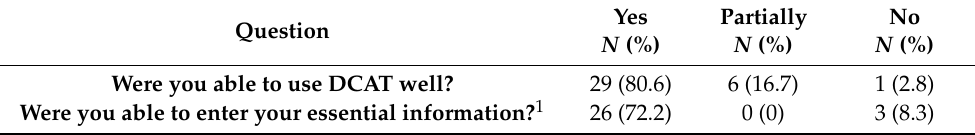
Table 3. Patients’ assessment after using the digital communication assistance tool (DCAT).